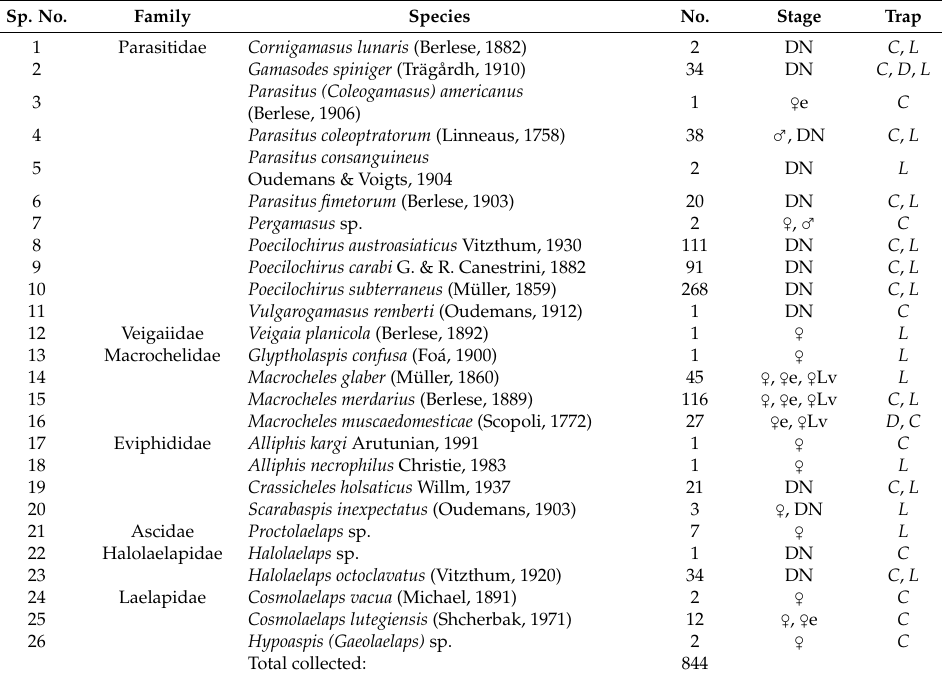
Table 1. Mites collected from April to June